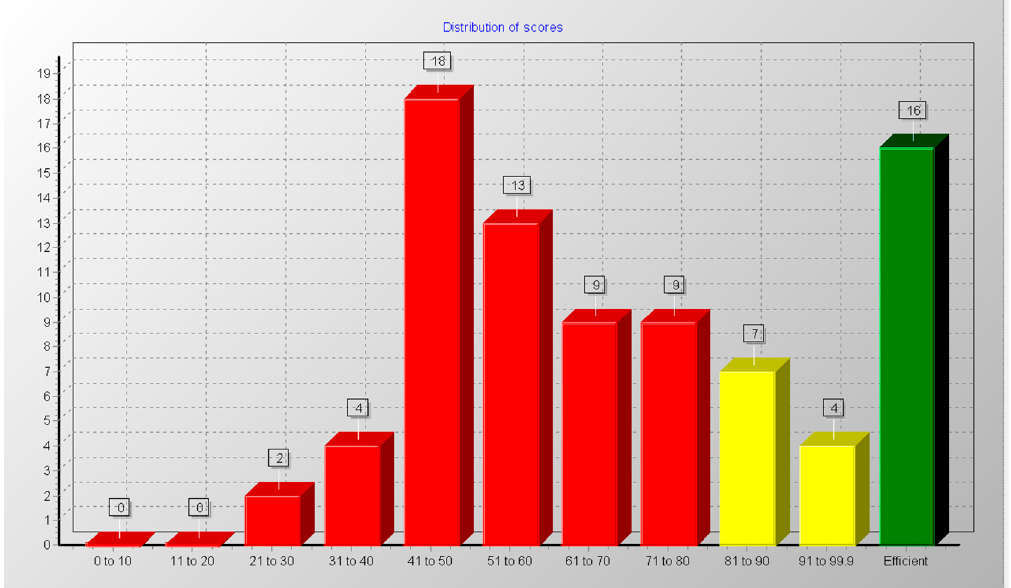
Figure 8. CCR Model Maximum Focused Method Score Distribution.